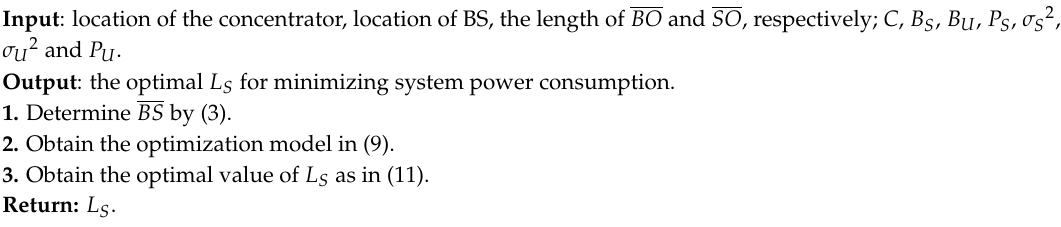
Algorithm 1 Location of UAV (LU) algorithm.